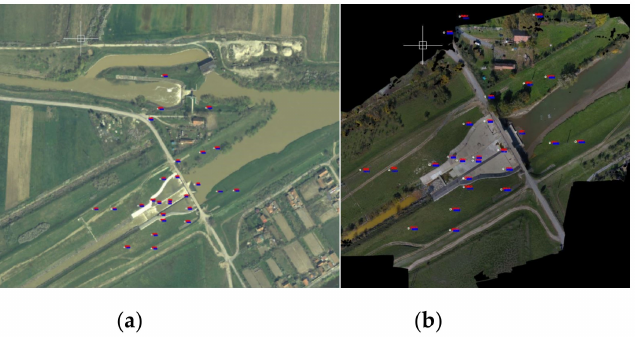
Figure 14. Orthophotoplan obtained by aerial data processing, Topolov ă ¸tu Mic, Timis A comparative analysis of the resulting georeferencing data was also made by com- paring two orthophotoplans: one from 2015, made by the ANCPI and the the second one conducted in the research in 2018. Figure 15a,b shows the georeference orthophotoplan for HN Topolov ă ¸tu Mic.